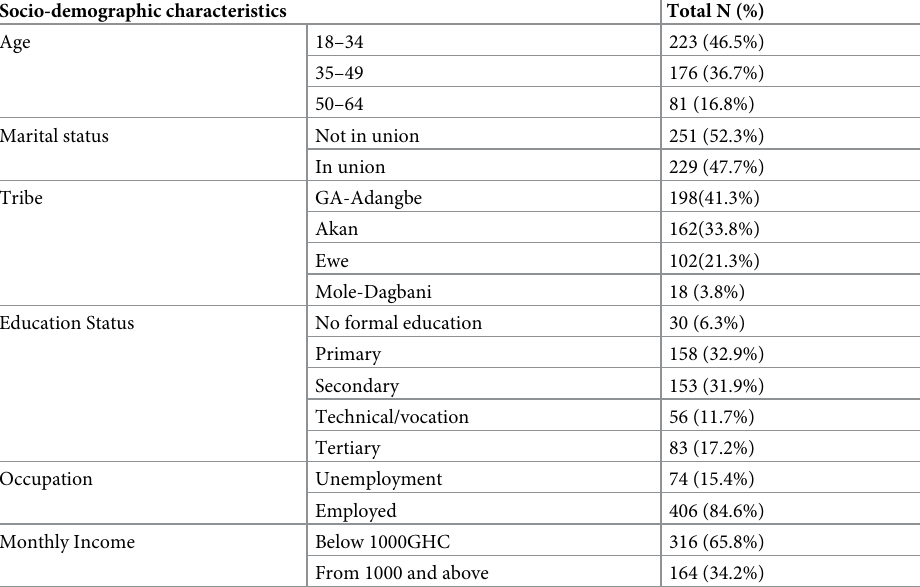
Table 1. Socio-demographic characteristics of participants (n =